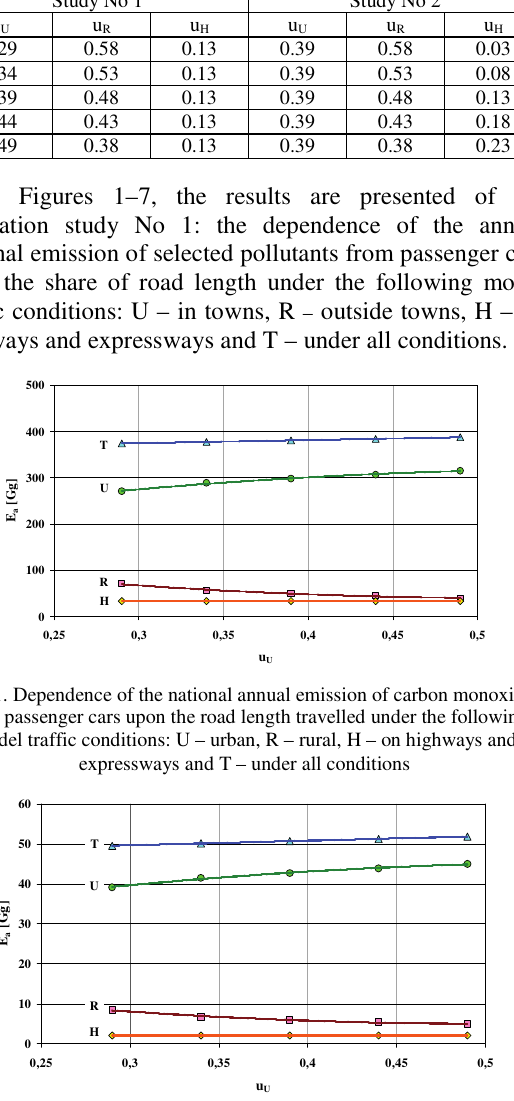
Fig. 2. Dependence of the national annual emission of volatile organic compounds from passenger cars upon the road length travelled under the following model traffic conditions: U – urban, R – rural, H – on highways and expressways and T – under all conditions